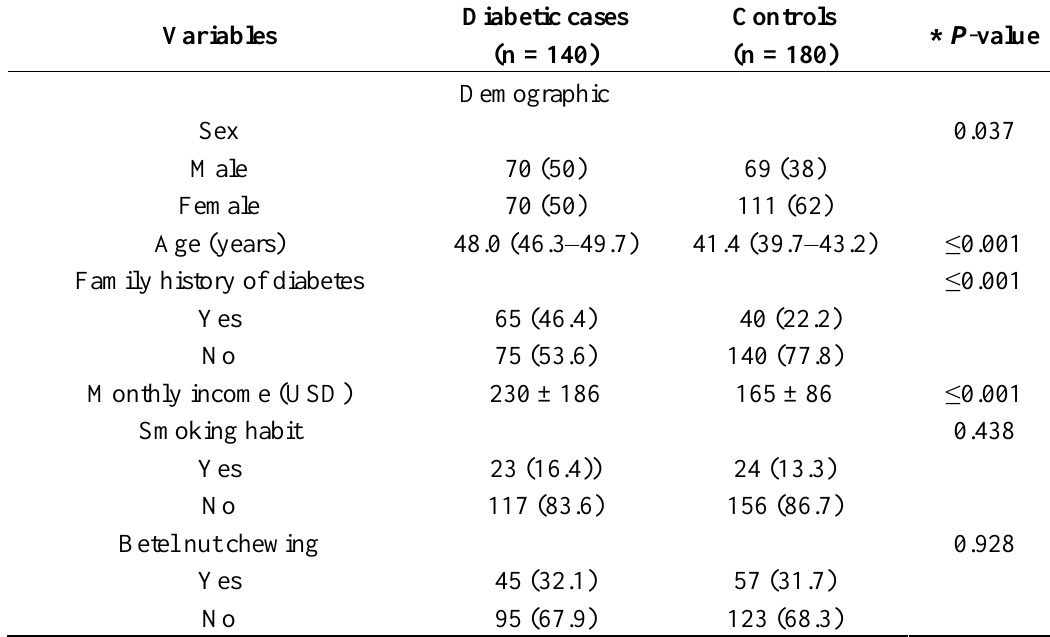
Table 1. Means and percentages of diabetic cases and controls, Faridpur,